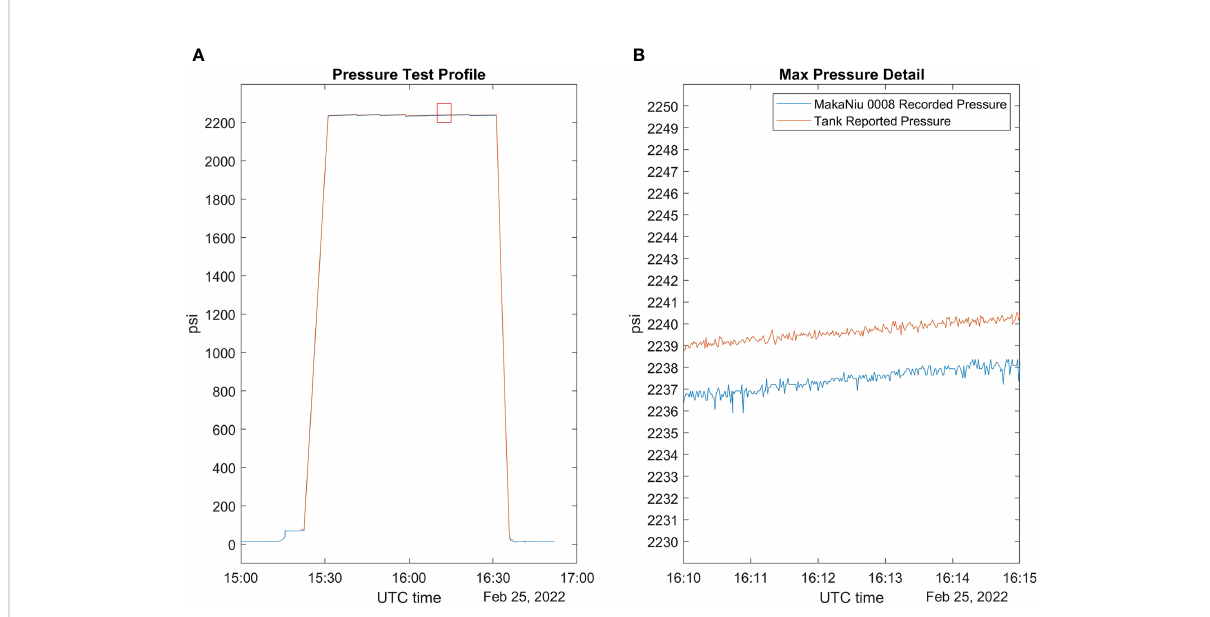
FIGURE 11 (A) Pro fi le of the entire duration of the test, which pressurized the Maka Niu to approximately 2,235 psi. (B) A closeup of the pressures reported at the maximum pressure range, showing a difference of approximately 2 psi between the reported and recorded